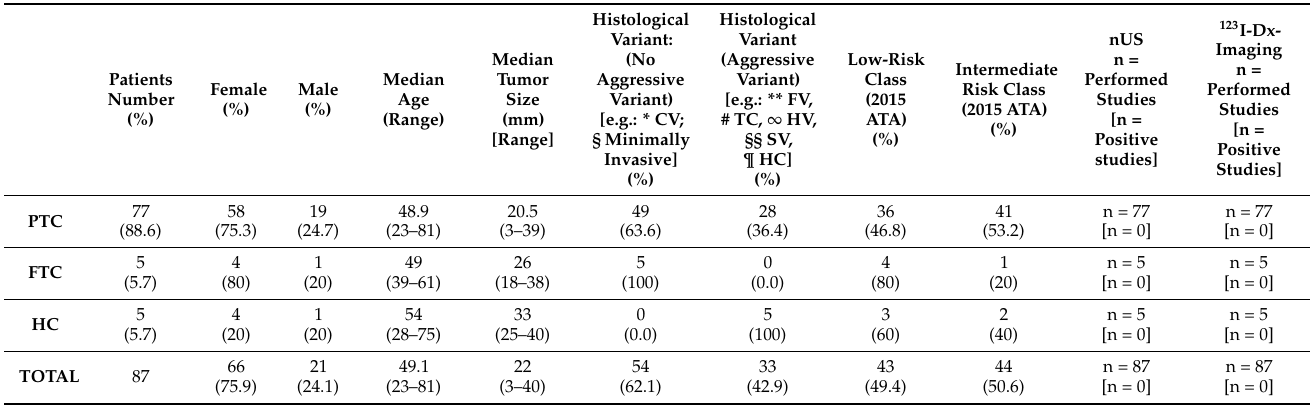
Table 2. Demographic, clinical, pathological and imaging data of the patients with excellent response (ER) to initial treatments (Group